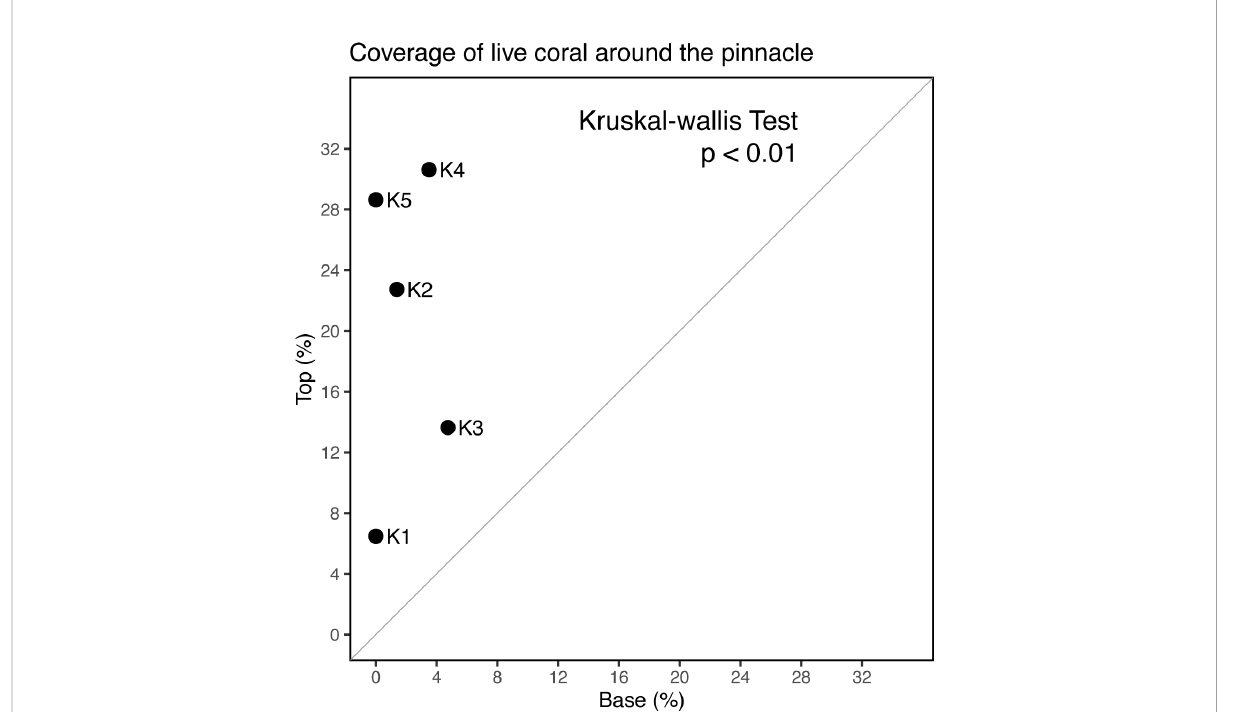
FIGURE 9 Comparison of live coral cover on the tops and bases of pinnacle-top patch reefs in the Dongsha Atoll lagoon. The living coral cover on the tops of the pinnacle-top patch reefs was signi fi cantly higher than that on the bases.